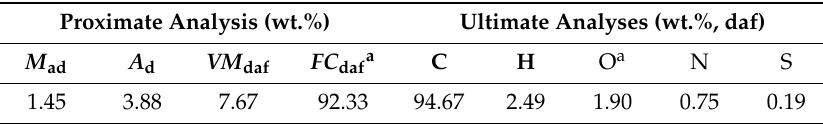
Table 2. Proximate and ultimate analyses of Taixi anthracite. Proximate analysis (wt.%)